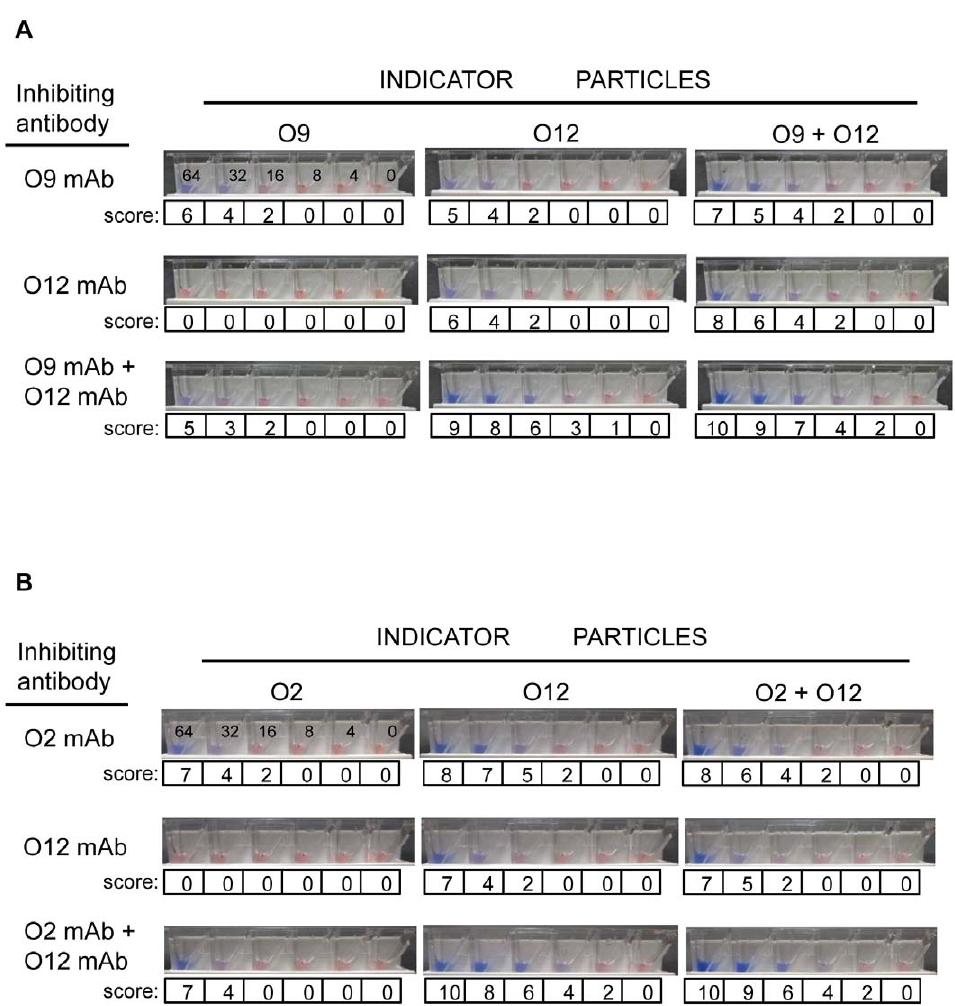
Figure 2. Pictoral results showing efficacy of various TUBEX tests in detecting mAb-spiked test samples. Various mAb-indicators (anti- O9, anti-O2 or anti-O12b) in conjunction with O9 LPS- (A) or O2 LPS-coupled (B) magnetic particles to detect various types of purified mAbs (anti-O9, anti-O2 or anti-O12b, or combinations of these). Numericals in microwells denote individual mAb concentration ( m g/ml), same for all sets of microwells; ‘score’ denotes TUBEX results.